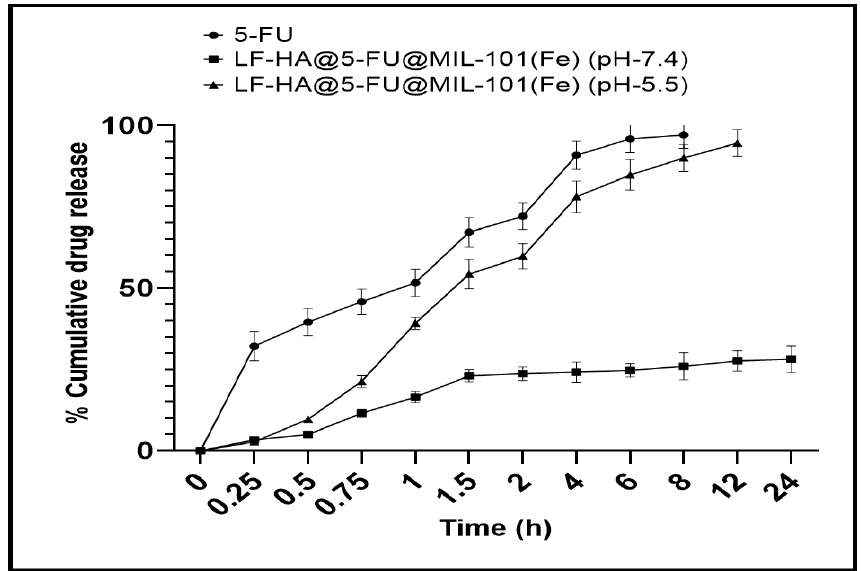
Figure 9. In vitro drug release data of 5-FU from the SM-MIL NPs in different pH media.